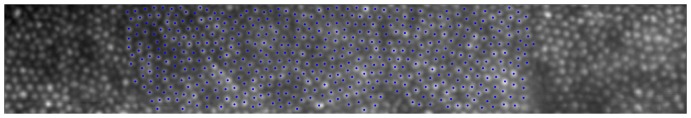
Average cone image for all sequences, used as master image for cone labeling.Imaged area is ∼1° inferior to fixation, and is within the foveal avascular zone. Labeled cone centres are marked in blue (n = 510). The average of corresponding frames in all sequences is presented as a pseudo-sequence in Media S1, which is cropped so that only pixels that were illuminated in every sequence are shown. The limited vertical extent of the field facilitates high frame rate acquisition with the sCMOS hardware.